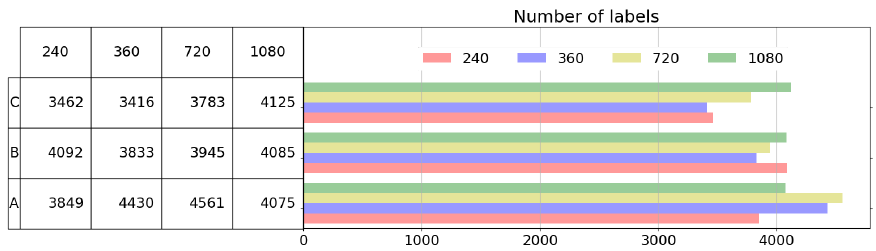
Figure 8. Number of labels obtained at different resolutions for